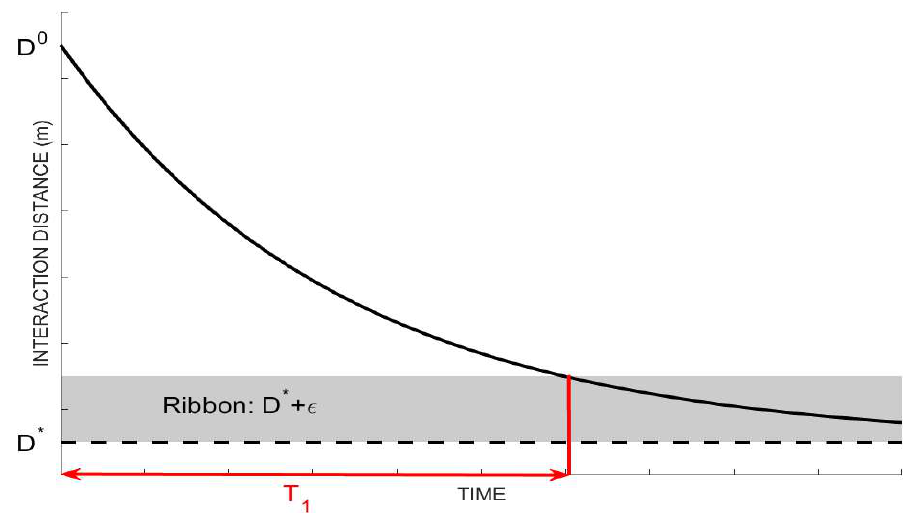
Figure 2. Illustration of rate of social resistance λ 1 by the given data for T 1